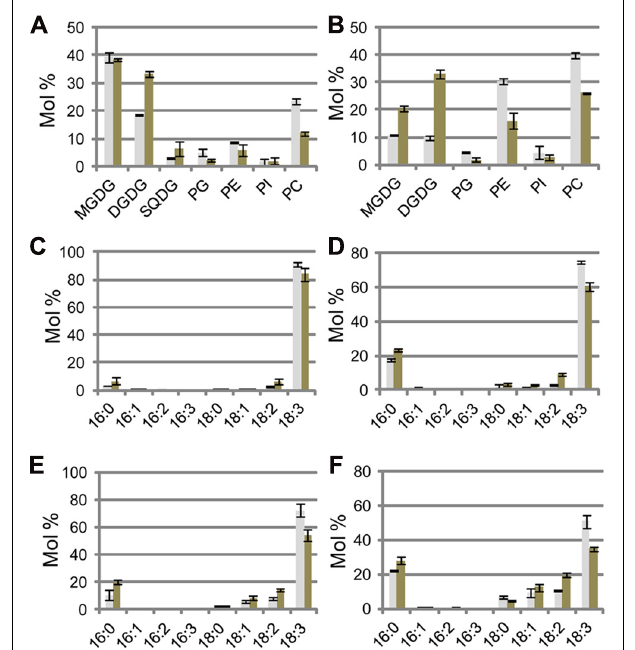
FIGURE 2 | Lipid analysis of sesame seedlings under phosphate (Pi)-sufficient and Pi-depleted conditions. (A,B) Molar ratio of membrane lipids of shoots (A) and roots (B) . Fatty acid compositions of MGDG (C,E) and DGDG (D,F) in shoots (C,D) and roots (E,F) . Gray bars and black bars indicate Pi-sufficient and Pi-depleted conditions, respectively. MGDG, monogalactosyldiacylglycerol; DGDG, digalactosyldiacylglycerol; PC, phosphatidylcholine; PE, phosphatidylethanolamine; PG, phosphati- dylglycerol; PI, phosphatidylinositol; SQDG, sulfoquinovosyldiacylglycerol. Values represent the mean ± SD from three independent